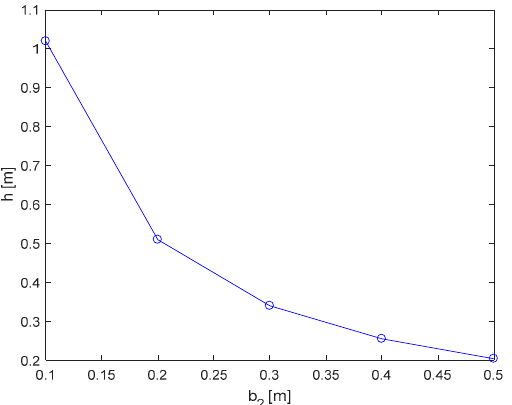
Figure 31. Critical values of height and position of the AGV CM to cause capsizing.